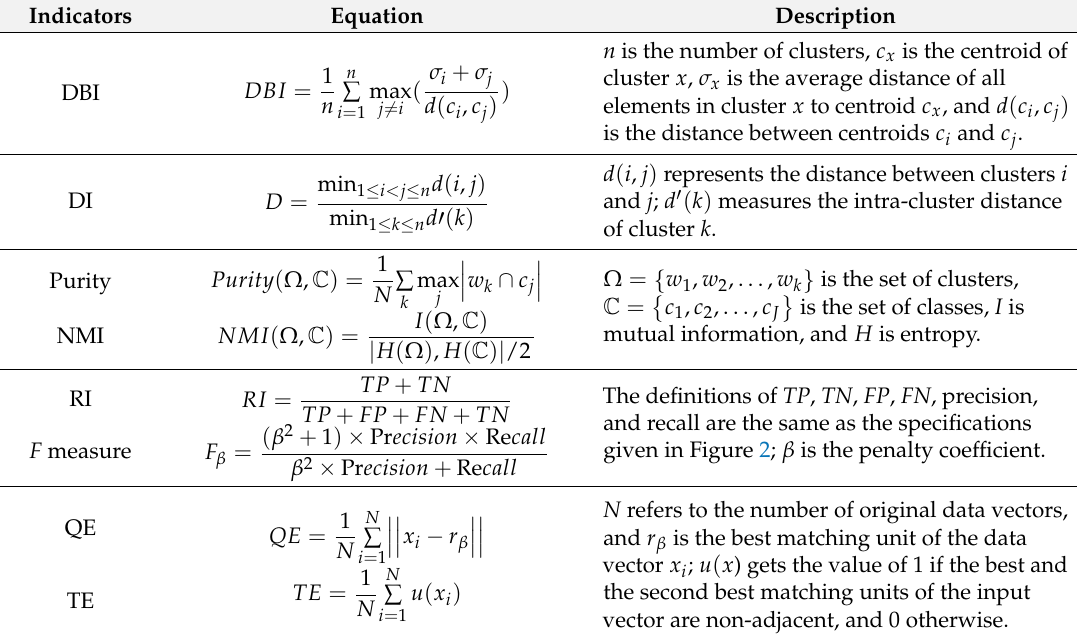
Table 4. The performance indicators for the clustering function [24].